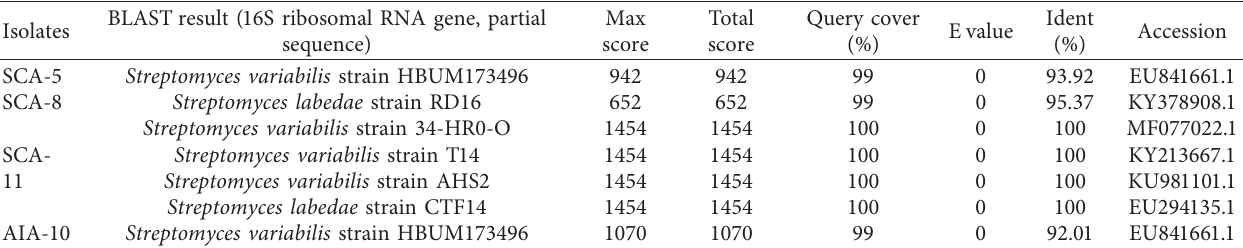
Table 2: The results of gene sequence alignments of 16S rRNA selected Streptomyces isolates to data available at NCBI (BLASTN). BLAST result (16S ribosomal RNA gene, partial Isolates